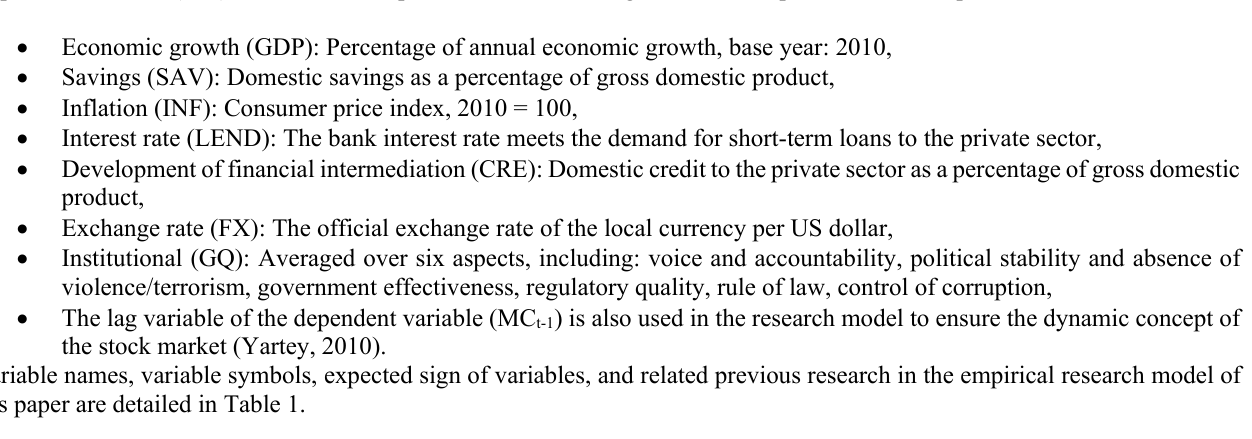
Definition, variable symbols, expected sign of variables, and previous studies in the empirical research model Variable names Variable